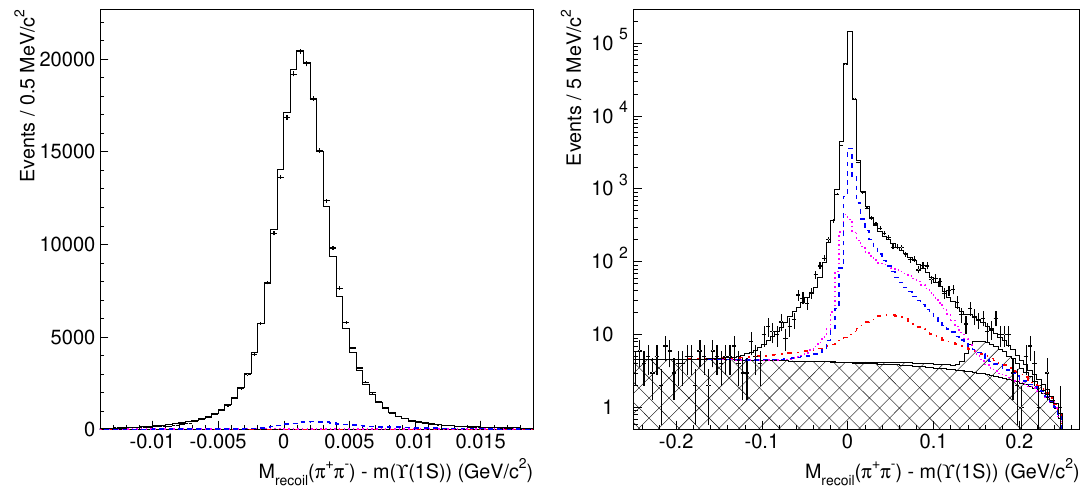
Figure 3 . The M recoil ( (cid:25) + (cid:25) (cid:0) ) (cid:0) m ((cid:7)(1 S )) distribution for the data collected at the (cid:7)(2 S ) reso- nance (points with error bars) and (cid:12)t results (black solid histogram). Also shown are combinatorial background (cross-hatched histogram), background from (cid:17) decays (hatched histogram) and vari- ous contributions to the signal function: FSR with E (cid:13) > 0 : 1 MeV (blue dashed), decays in (cid:13)ight (magenta dotted) and secondary interactions (red dash-dotted). Both panels show the same dis- tribution, but di(cid:11)er in bin sizes, linear or logarithmic scales of the vertical axes and ranges of the horizontal